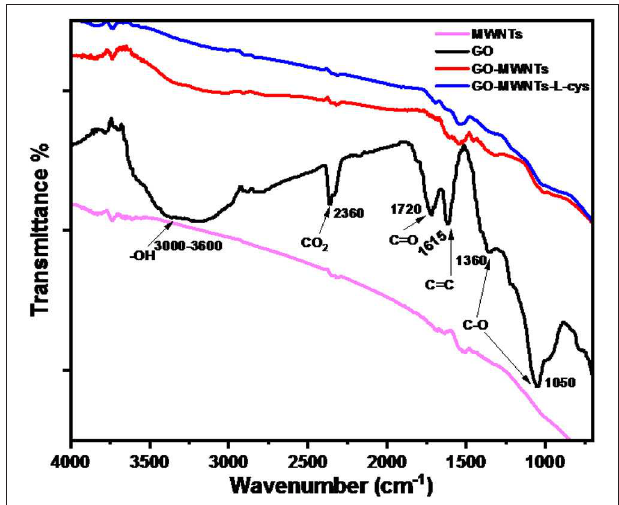
FIGURE 1 | FTIR spectra of functional MWNTs, GO, GO–MWNTs, and GO–MWNTs–L-cys from down to up,